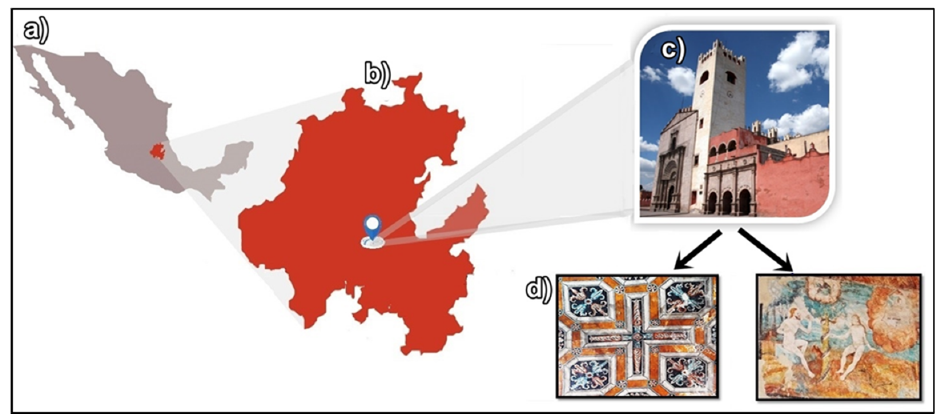
Figure 1. ( a ) Geolocation map of the state of Hidalgo Mexico at the coordinates 20°16 ′ 06 ″ N 98°56 ′ 35 ″ W; ( b ) geolocation map of the convent of San Nicolás de Tolentino at the coordinates 20°16 ′ 6.24 ″ N, 98 ◦ 56 (cid:48) 35 (cid:48)(cid:48) W; ( b ) geolocation map of the convent of San Nicol á s de Tolentino at the coordinates 98°56 ′ 34.8 ″ W; ( c ) the main facade of the convent of San Nicolás de Tolentino; and ( d ) samples of 20 ◦ 16 (cid:48) 6.24 (cid:48)(cid:48) N, 98 ◦ 56 (cid:48) 34.8 (cid:48)(cid:48) W; ( c ) the main facade of the convent of San Nicol á s de Tolentino; and mural paintings from the convent: geometric themes of the barrel vault (left) and the garden of Eden ( d ) samples of mural paintings from the convent: geometric themes of the barrel vault ( left ) and the (right). garden of Eden ( right